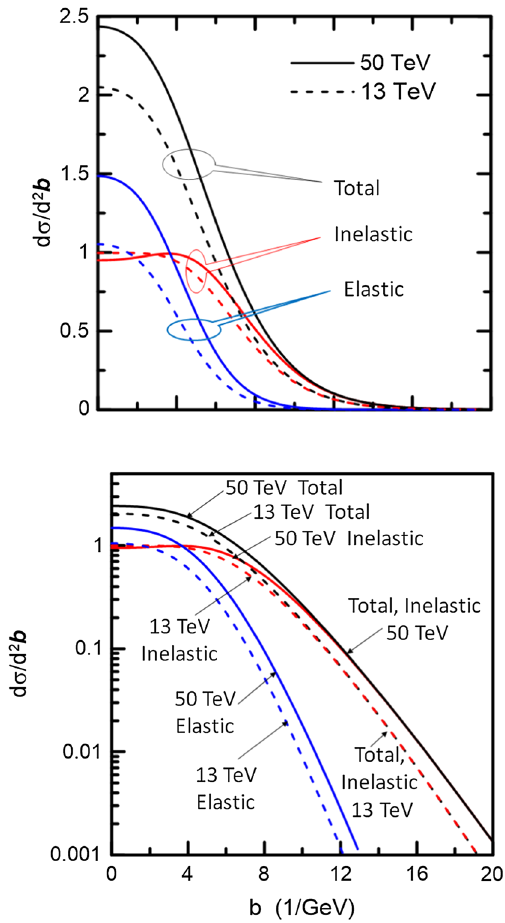
Fig. 12 Differential cross sections in b -space at energies 13 and 50 TeV. At b = 0 the ratio of differential cross sections elastic/inelastic increasesfrom1.06at13TeVto1.56at50TeV.Astheenergyincreases, the interaction at the center of the proton becomes increasingly elastic. On the other hand, the integrated cross section is dominantly inelastic, as its range is more extended and the value is favored by the b factor in the integration. For more clarity, the figure is repeated in log scale